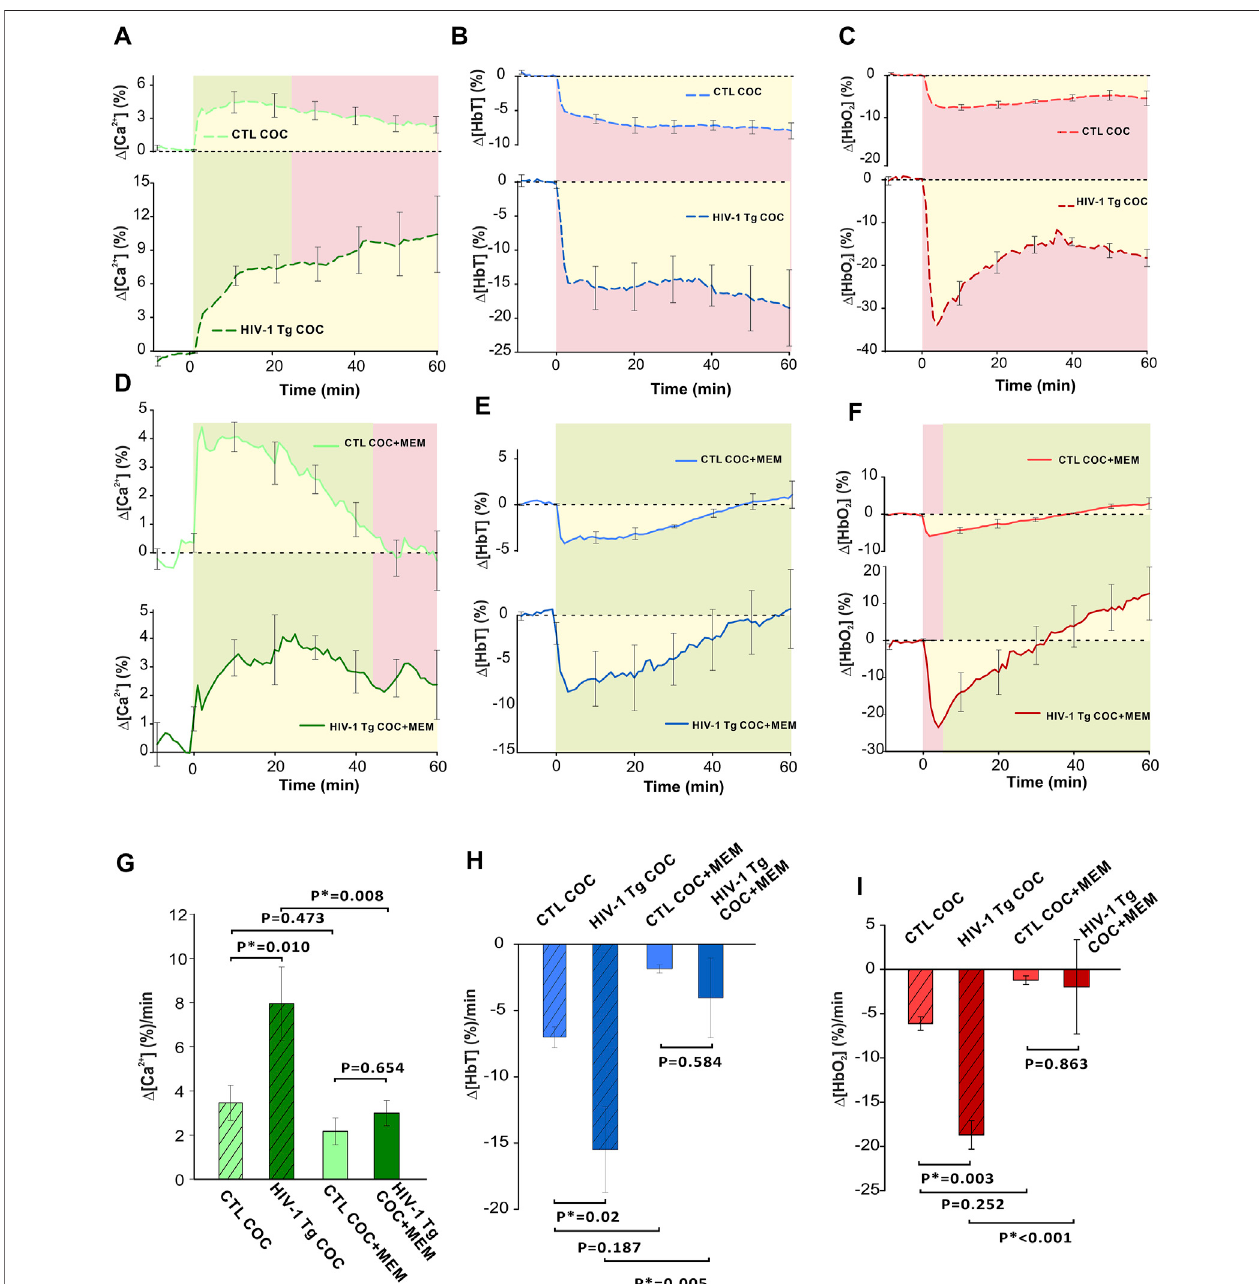
FIGURE9| Comparisonofcocaine-inducedchangesbetweencontrolandtransgenicHIV-1Tganimalswithsalineormemantinepretreatment. (A) Timecourseof neuronal response to cocaine in HIV-1 Tg and control (F344 non-Tg) rats showing the variation in response to cocaine (1 mg/kg, i.v.). In control rats, Δ [Ca 2+ ] i peak was followed by a slow decay, whereas HIV-1 Tg rats display a long, persistent increase in neuronal Δ [Ca 2+ ] i . (B) HIV-1 Tg rats had a greater reduction in total hemoglobin ( Δ [HbT]) as well as (C) a rapid decrease in oxygenated hemoglobin ( Δ [HbO 2 ]) followed by a slight recovery from -30% to -20% that remained decreased over 60 min. (D) Memantine-pretreatedHIV-1Tgratshadasimilar Δ [Ca 2+ ] i responsetococaineascontrolanimals.However,controlanimalsreturnedtobaselinewhereHIV- 1 Tg animals did not. (E) Time courses of control and HIV-1 Tg rat responses to cocaine showed similar temporal pro fi les in Δ [HbT] reductions. (F) Cocaine-induced Δ [HbO – I) HIV-1 Tg rats accumulated more 2 ] peak reduction was larger in HIV-1 Tg than in control rats. However, they returned to baseline at the same time. (G intracellularneuronalCa 2+ anddemonstratedsigni fi cantlygreaterreductionsintotalandoxygenatedhemoglobin.Theseenhancedresponsesweresigni fi cantlyreduced following memantine pretreatment in HIV-1 Tg. Green shaded area: no signi fi cant difference between curves. Red shaded area denotes signi fi cant differences between curves. Yellow area indicates the area quanti fi ed for the average rate of change for Δ [Ca 2+ ] i , Δ [HbT], and Δ [HbO 2 ]. *: p < 0.05, signi fi cant difference.